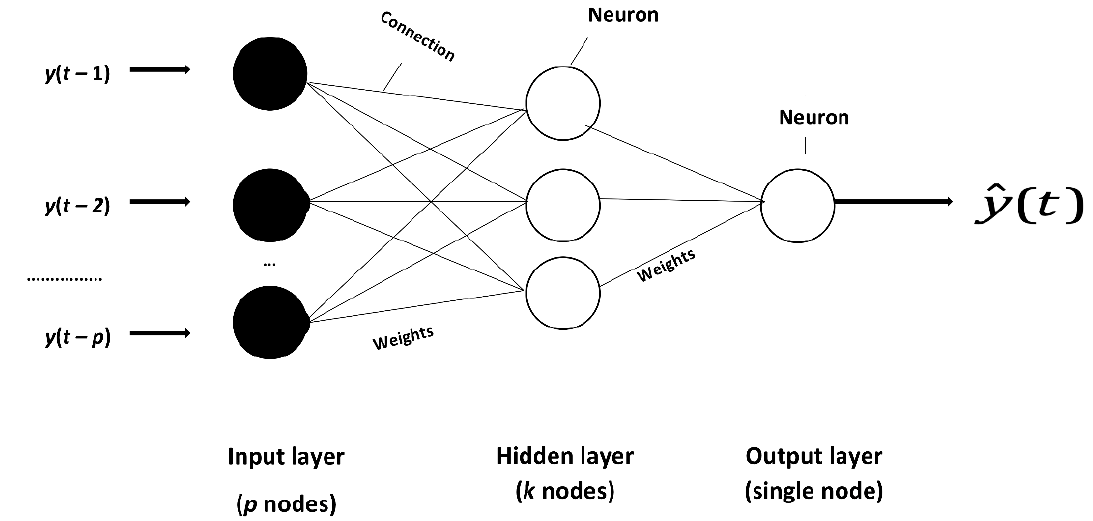
Figure 7. A general form of a three-layer FFNN structure with lagged inputs.